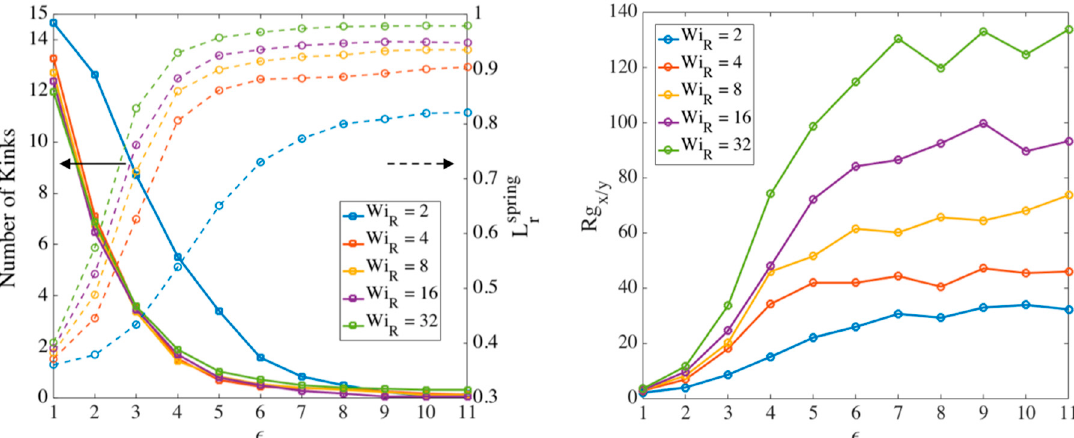
Figure 12. Evolution of (left) number of kinks (left axis) and averaged extension of springs (right axis) and (right) relative radius of gyration ( Rg x / y ) for a chain with N s = 32 at different Weissenberg from slip-spring simulations with maximum entanglement force (MEF) condition. The averaged extension of springs is calculated using Equation (14).